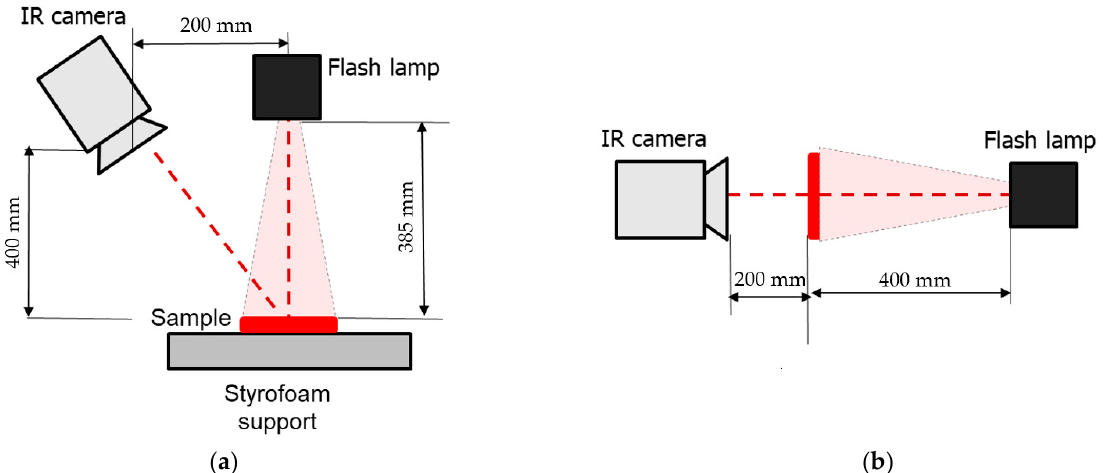
Figure 5. Thermal NDT procedures: ( a ) reflection mode, ( b ) transmission mode.